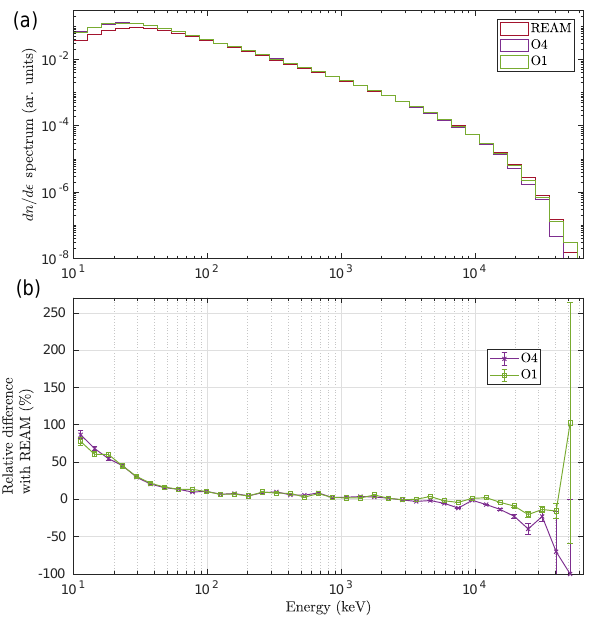
Figure 8. (a) Photon energy spectra of Geant4 (O4 and O1) and REAM for E = 0 . 80MVm − 1 , recorded at z = 128m. (b) Relative difference between Geant4 (O1 and O4) and REAM. The error bars are calculated from the Poisson